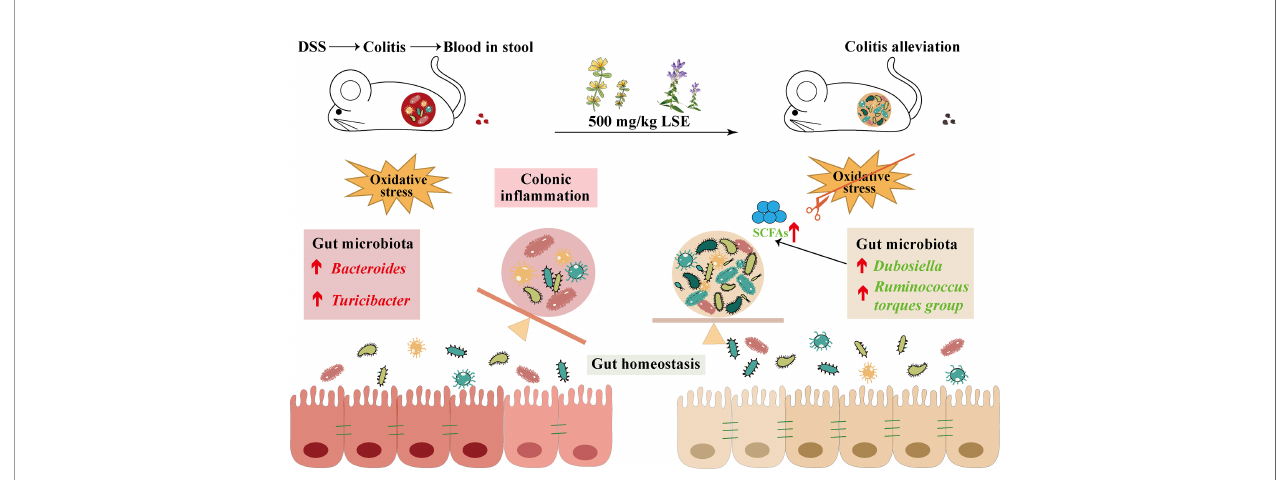
FIGURE 9 | LSE supplementation can alleviate colonic in fl ammation by regulating oxidative stress and gut microbiota community in DSS-induced colitis mice: a possible